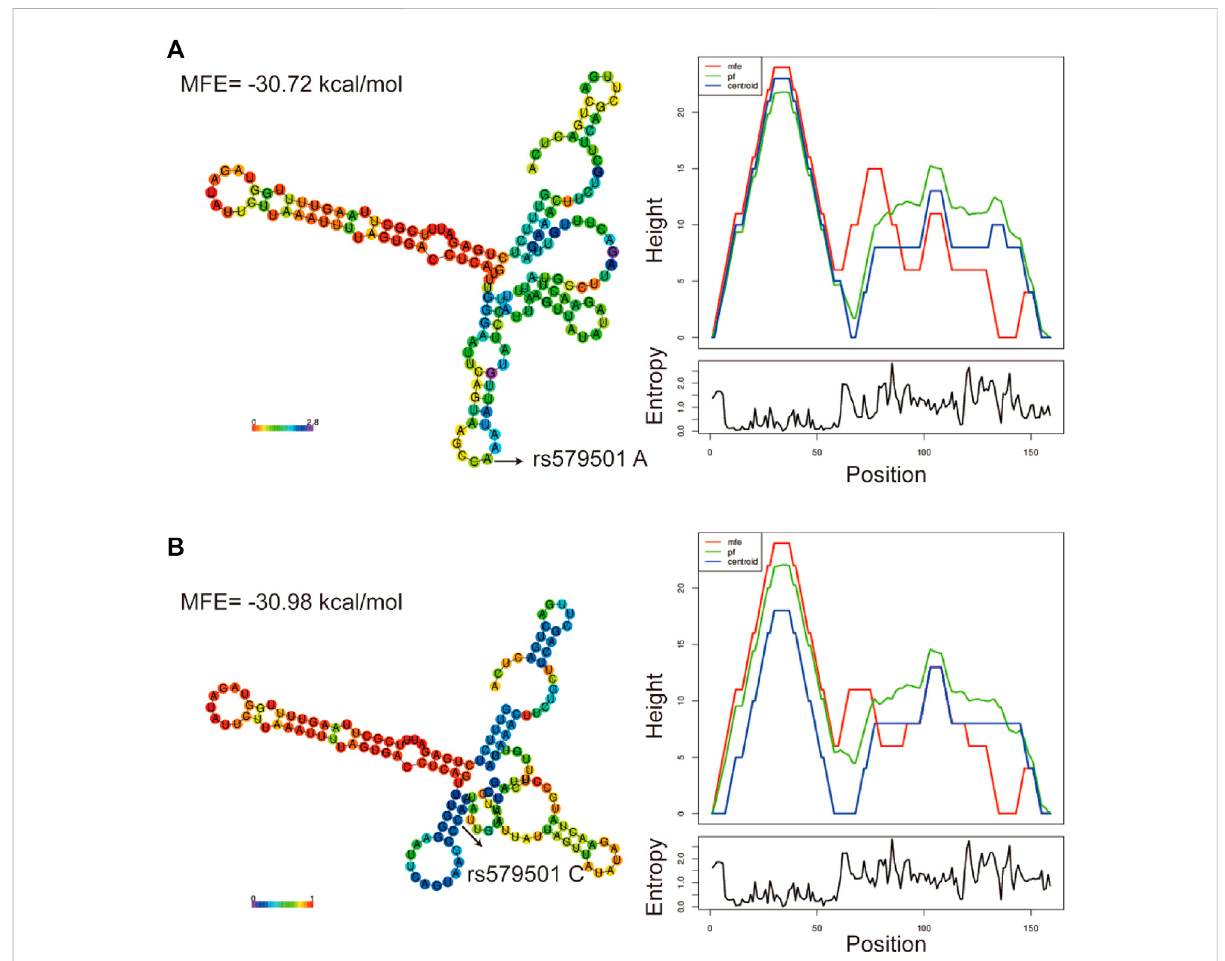
FIGURE 1 Bioinformatic prediction of lnc-ZNF33B-2:1 polymorphism on centroid secondary structure. (A) Centroid secondary structure and a mountain plot representation of the MFE structure of rs579501 A allele; (B) centroid secondary structure and a mountain plot representation of the MFE structure of rs579501 C allele.